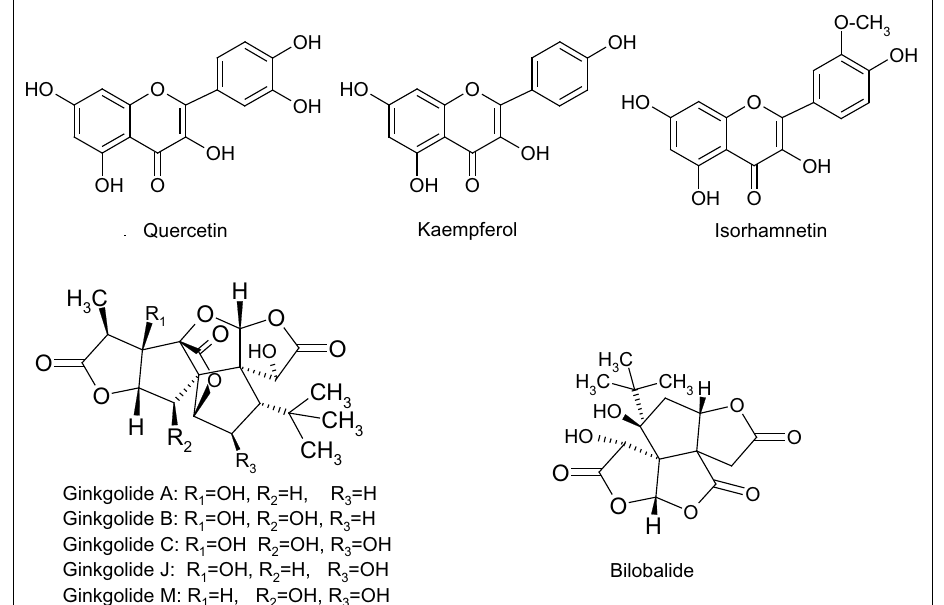
Figure 2. Main flavonoids (quercetin, kaempferol and isorhamnetin), ginkgolides (A, B, C, J, M) and bilobalide of Ginkgo biloba